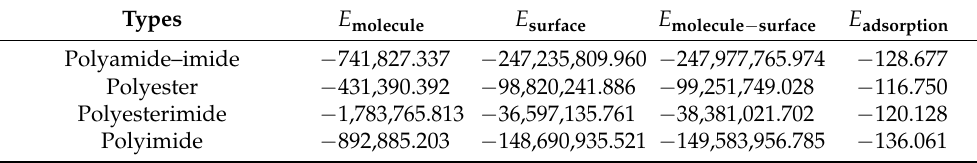
Figure 3. Top view of adsorption sites for PAI, PEI, PET and PI. Table 1. The adsorption energy calculation process and results of PAI, PET, PEI and PI.